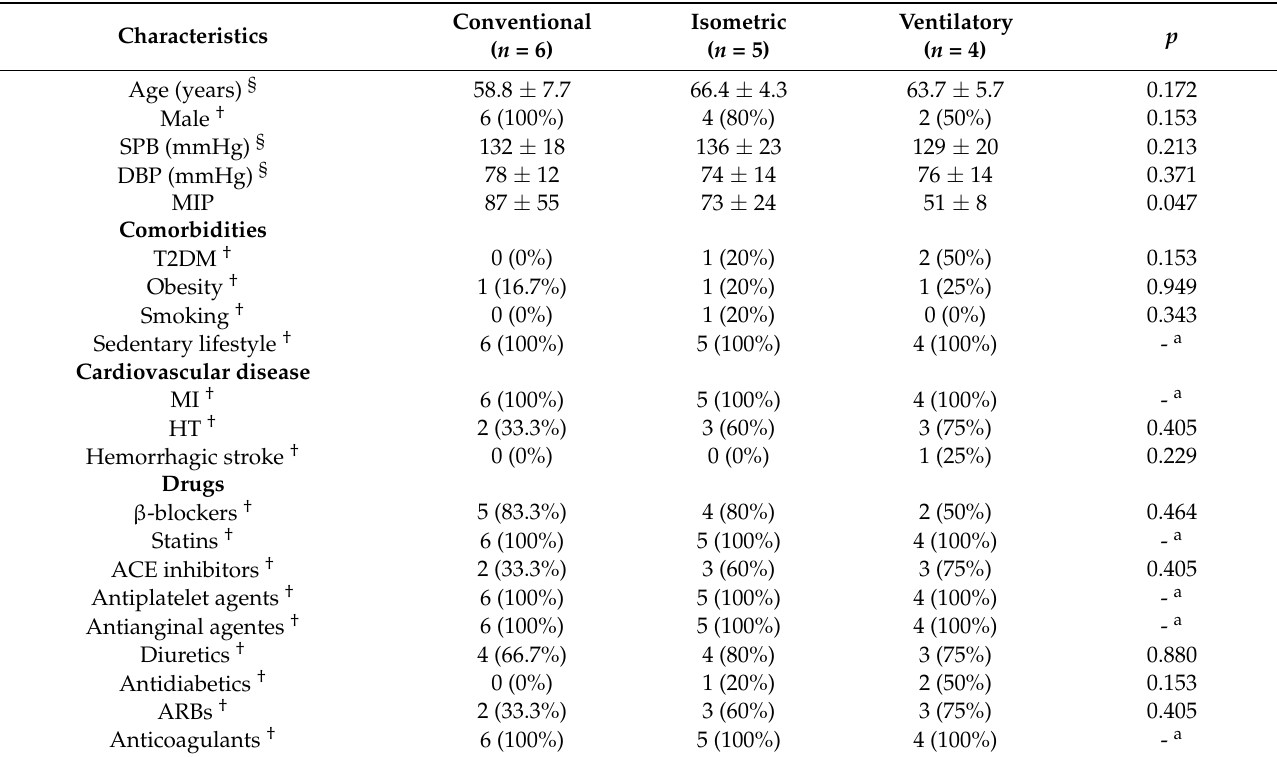
§ variable described as mean ± standard deviation (SD); † variable described as frequency; SBP: systolic blood pressure; DBP: diastolic blood pressure; MIP: maximal inspiratory pressure; T2DM: Type 2 diabetes mellitus; MI: acute myocardial infarction; HT: systemic hypertension; ACE: